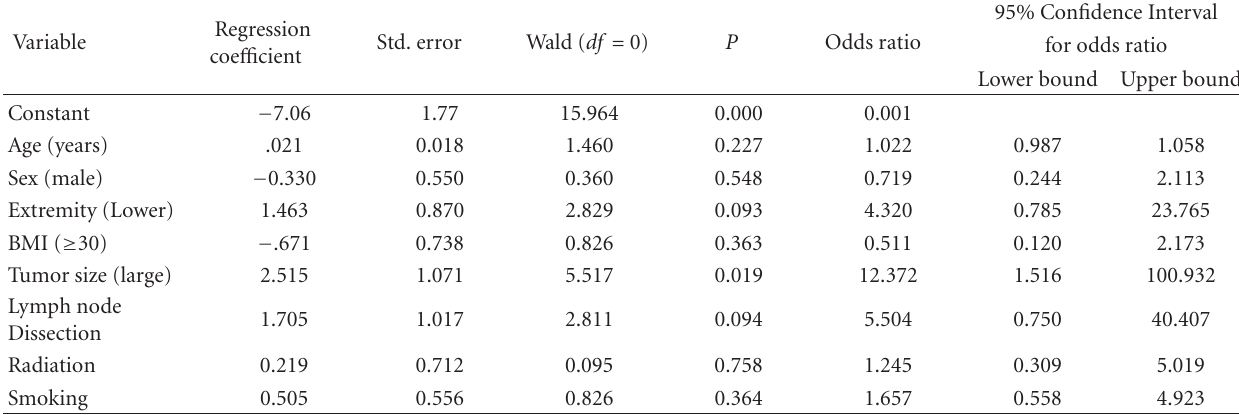
Table 4: Logistic regression coe ffi cients with Corresponding P values, odds ratios, and 95% confidence intervals of the odds